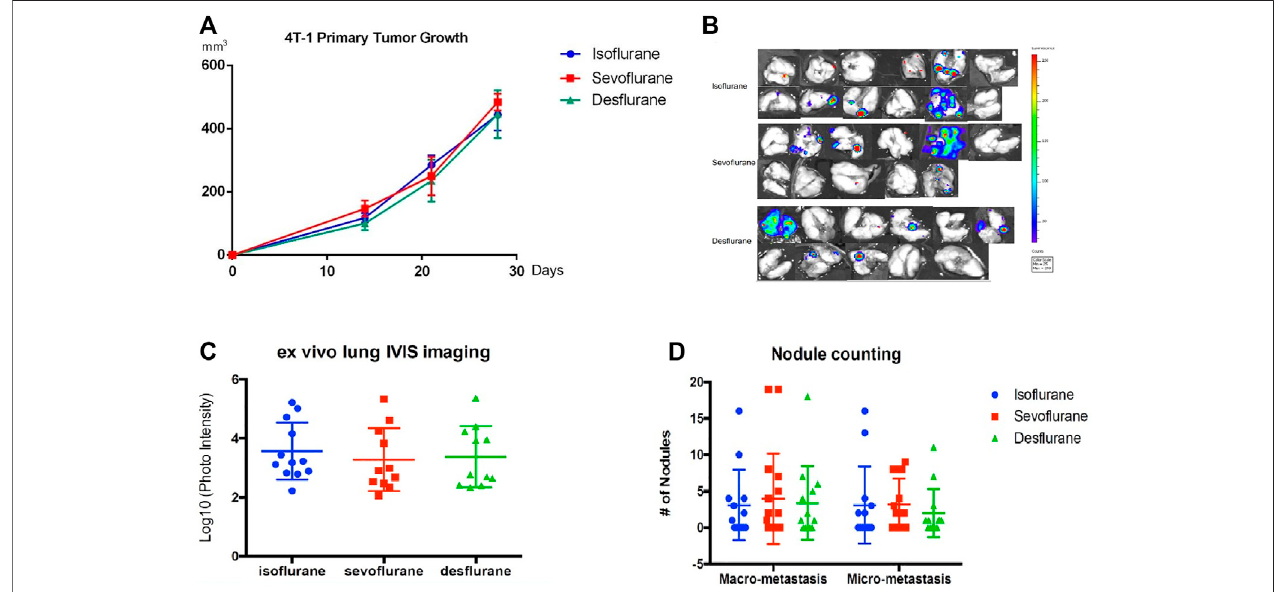
FIGURE 3 | No signi fi cant difference in the lung metastasis following mastectomy with different inhaled anesthetics. Mice bearing primary tumors were generated by orthotopical implantation with the luciferase-tagged murine 4T1 breast cancer cells in the mammary fat pads of balb/c mice ( n = 12 for iso fl urane group, n = 11 for sevo fl urane group, and n = 11 for des fl urane group). Surgical dissection of primary tumor with 2% iso fl urane, 3.6% sevo fl urane, or 10.3% des fl urane. Mastectomy was performedinmicemodels,andlungmetastaseswereevaluated3 weeksaftersurgery. (A) Therewasnodifferenceintheprimarytumorvolumesamongiso fl urane, sevo fl urane, or des fl urane groups (iso fl urane vs. sevo fl urane, P = 0.901; iso fl urane vs. des fl urane, P = 0.847; sevo fl urane vs. des fl urane P = 0.645; one-way ANOVA + Tukey ’ smultiplecomparisonstest), (B) exvivo lungbioluminescentimaging,and (C) photonintensityofthemshowednosigni fi cantdifferenceinlungmetastasisamong iso fl urane, sevo fl urane, or des fl urane groups (iso fl urane vs. sevo fl urane, P = 0.778; iso fl urane vs. des fl urane, P = 0.899; sevo fl urane vs. des fl urane, P = 0.971). (D) The examination of number and size of metastatic nodules showed no signi fi cant difference among iso fl urane, sevo fl urane, or des fl urane groups (iso fl urane vs. sevo fl urane, P = 0.996; iso fl urane vs. des fl urane P = 0.993; sevo fl urane vs. des fl urane, P =